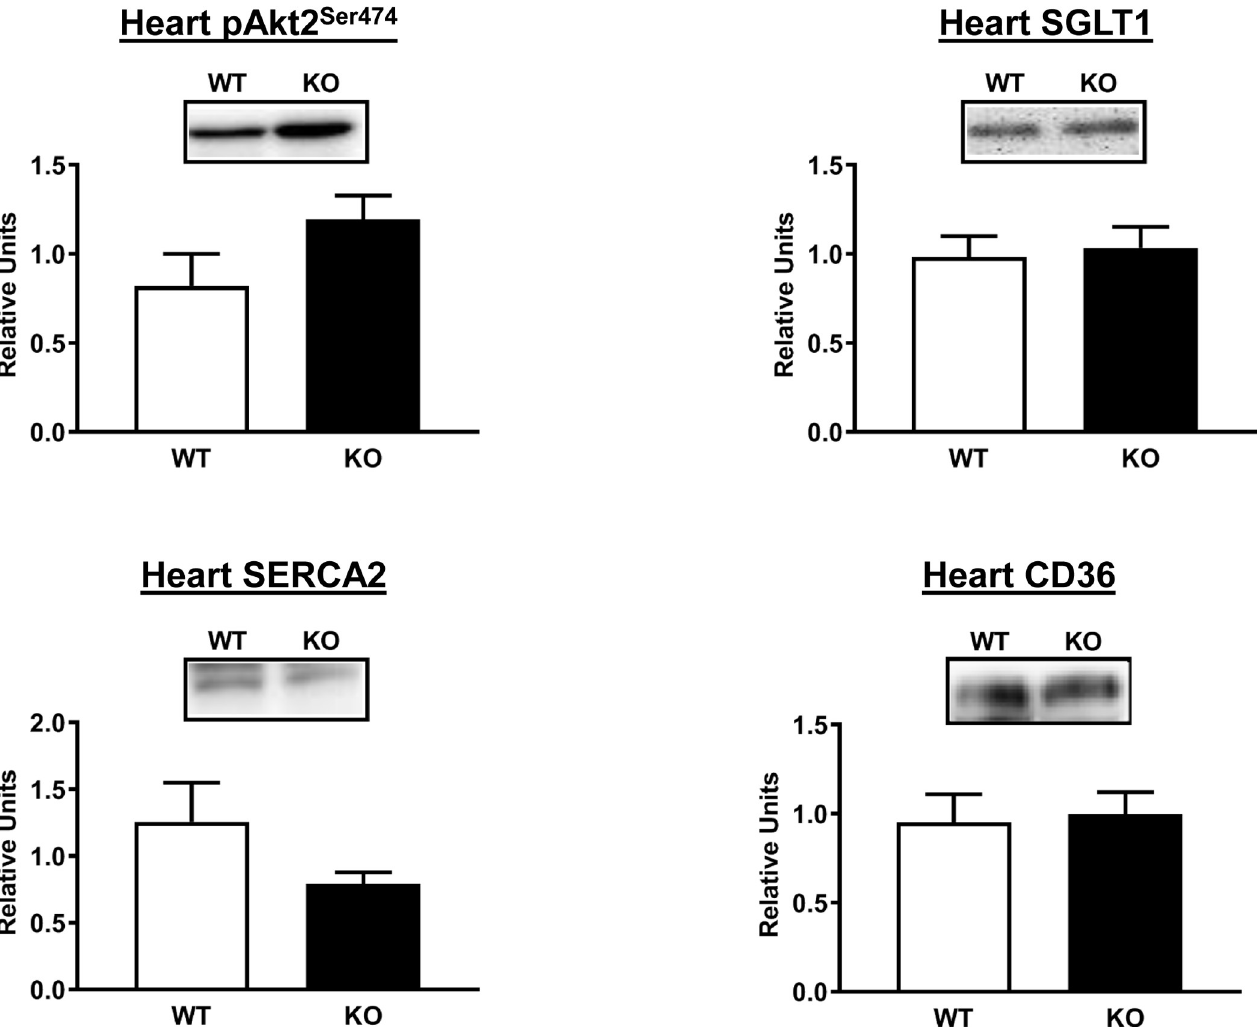
Fig 7. Akt2 phosphorylation on Ser 474 (pAkt2 Ser474 ) and abundance of SGLT1, SERCA2, and CD36 in heart from WT (white bars) and KO (black bars) animals subjected to the HEC. Means ± SEM for 4 rats of each genotype.